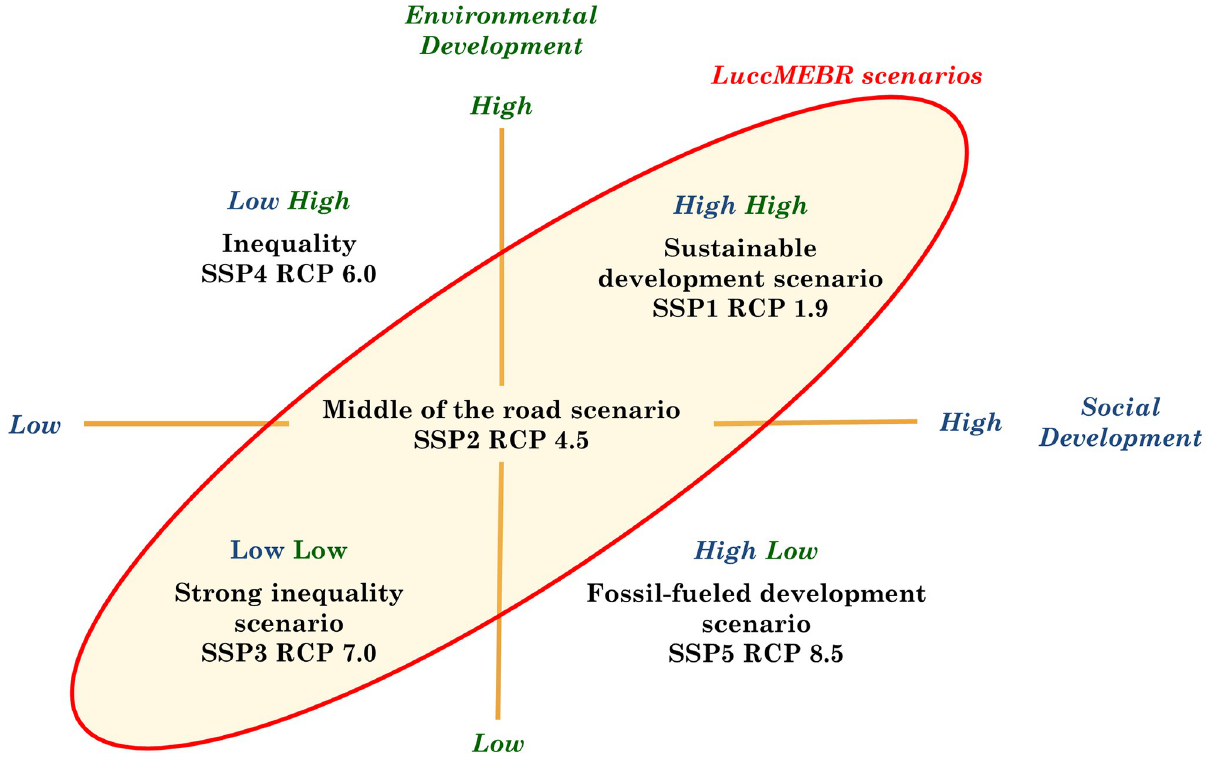
Fig 2. Representation of LuccMEBR